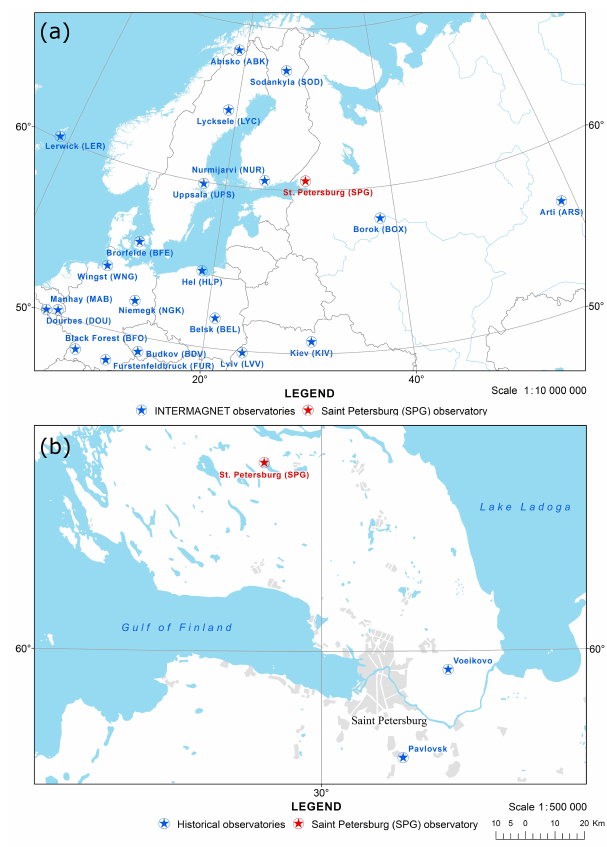
Figure 1. Geographical location of the Saint Petersburg observa- tory. Current geographical location in relation to other INTER- MAGNET observatories (a) and in relation to the historical obser- vatory sites Pavlovsk and Voeikovo (b)